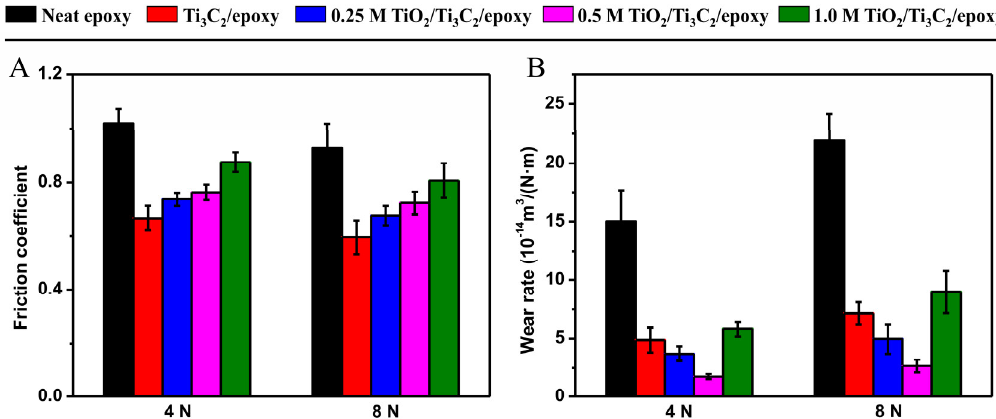
Figure 6. Friction coefficient ( A ) and wear rate ( B ) of neat epoxy, Ti 3 C 2 /epoxy, 0.25 M TiO 2 /Ti 3 C 2 /epoxy, 0.5 M TiO 2 /Ti 3 C 2 /epoxy, and 1.0 M TiO 2 /Ti 3 C 2 /epoxy nanocomposites at 0.5% mass fraction under the normal load of 4 N and 8 N.